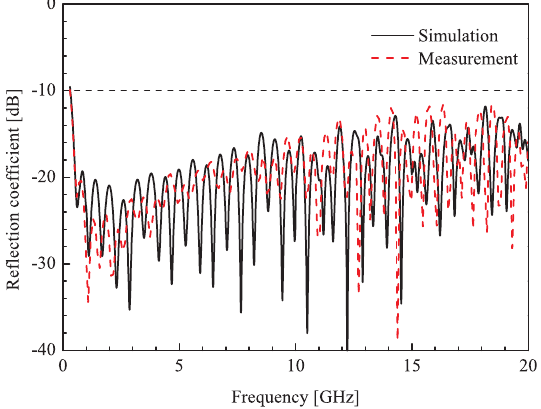
Figure 7. Simulated and measured reflection coefficients of the proposed